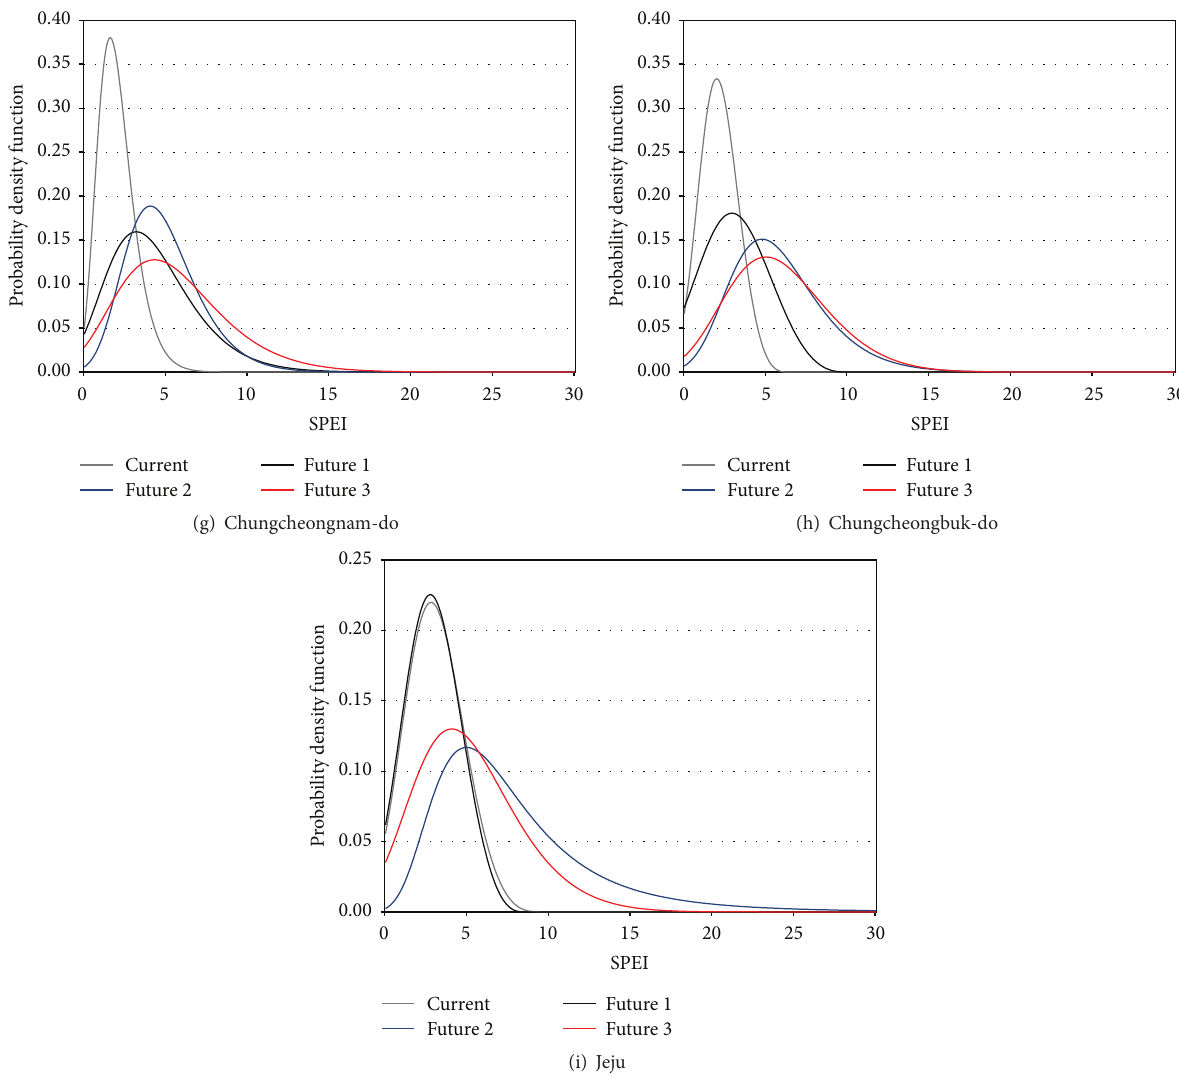
Figure 4: GEV PDF projection of total drought according to administrative